Question: Provide a publication-style caption for this figure.
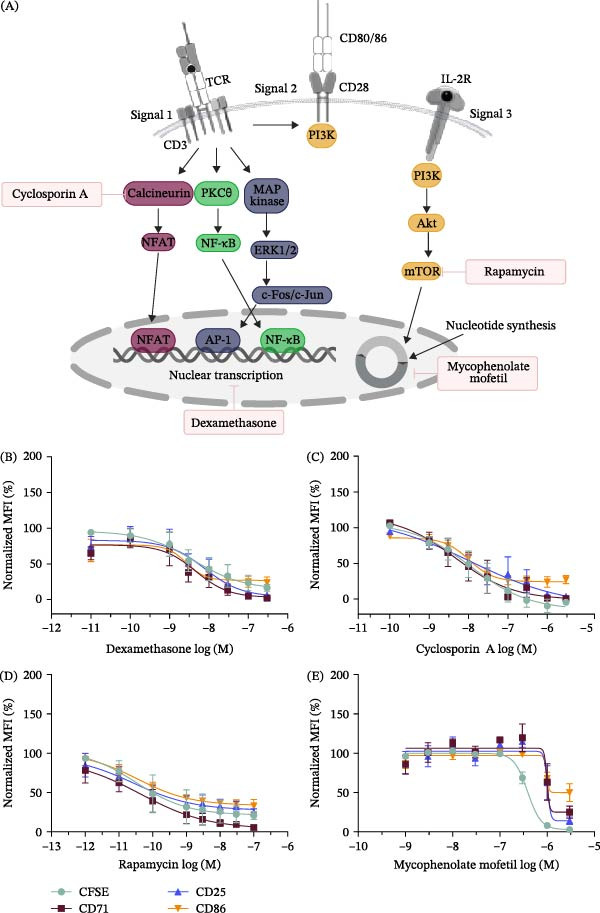
Answer: (A) Simplified schematic of the T cell signaling cascade and sites of action of known immunosuppressive drugs. Created in BioRender. Heger, L. (2025) https://BioRender.com/ssmk8hk . Dose response curves of dexamethasone (B), cyclosporin A (C), rapamycin (D), and mycophenolate mofetil (E) on T‐ and B‐cell activation markers. Data represent compound‐induced inhibition of T cell proliferation (CFSE), T‐cell activation (CD71, CD25), and B‐cell activation (CD86), normalized to unstimulated (0%) and anti‐CD3 stimulated (100%) cells. Experiments were performed in three independent experiments ( n = 3), each in duplicate. (F) pIC 50 values and maximal inhibitory effects (Emax) of immunosuppressive drugs. pIC 50 values were calculated from dose–response curves using a four‐parameter logistic (variable slope) fit. Emax represents the maximal observed inhibition (% relative to stimulated control) for each marker. Data are presented as mean ± standard deviation (SD).